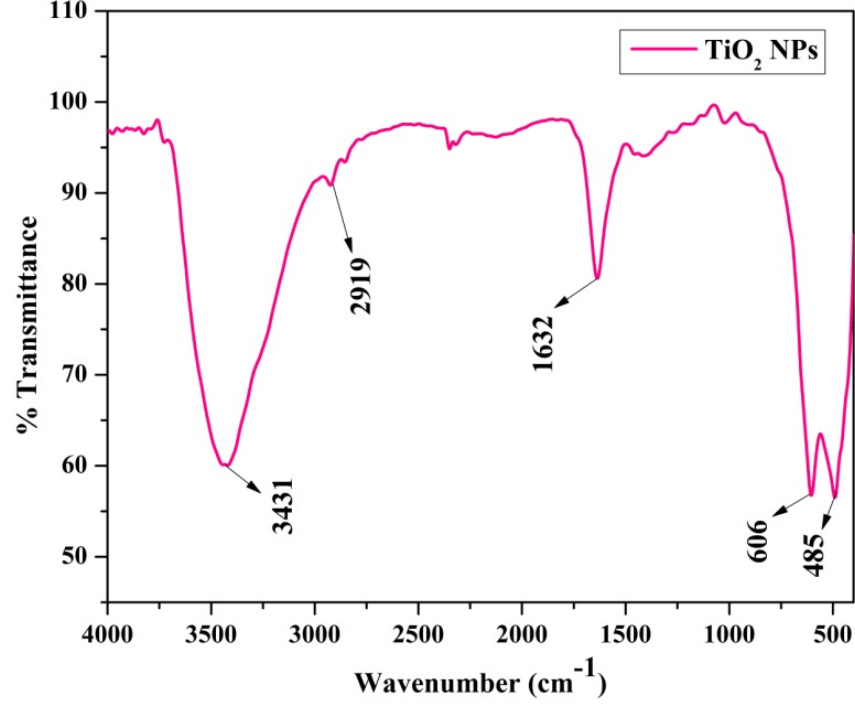
Figure 4. FTIR spectrophotometric analysis of TiO 2 nanoparticles.